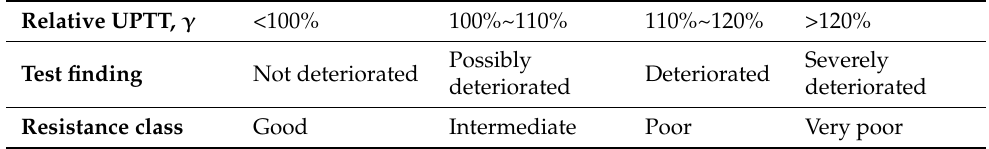
Table 2. Concrete classification by relative UPTT ( γ ) [52].